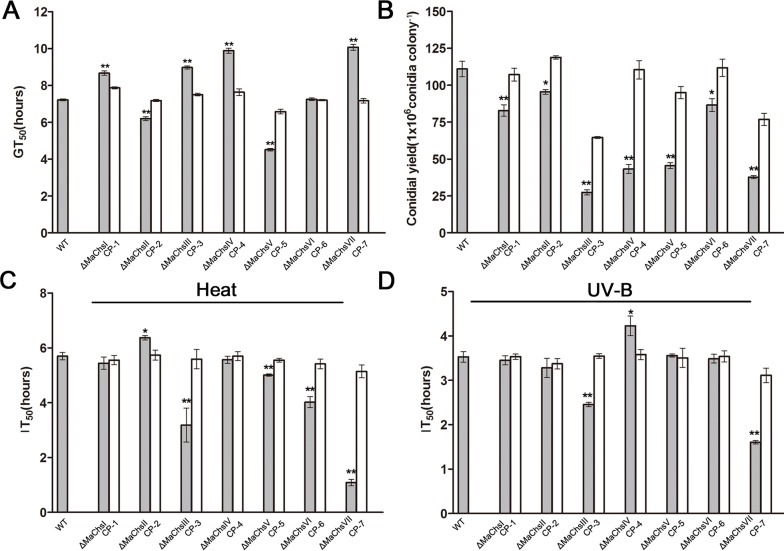
Measurement of conidial germination and yield, and fungal stress responses.(A) Germination time values for 50% germination (GT50) of conidia of wild type and ΔMaChs mutants. (B) Conidial yields of wild type and ΔMaChs mutants on 1/4 SDAY at 28°C for 15 d. (C) Inhibition time values for 50% germination (IT50) of wild type and ΔMaChs mutants by heat shock. IT50 estimates from the fitted trends of the conidial germination after exposure for 2, 4, and 6 h to of 45°C heat shock. (D) Inhibition time values for 50% germination (IT50) of wild type and ΔMaChs mutants by UV-B irradiation. IT50 estimates from the fitted trends of the conidial germination after exposure for 2, 4, and 6 h to UV-B irradiation of 1350 mW/m2. A single asterisk above bars denotes significant difference, P < 0.05; double asterisks above bars denote significant difference, P < 0.01. Error bars indicate standard errors of three trials.